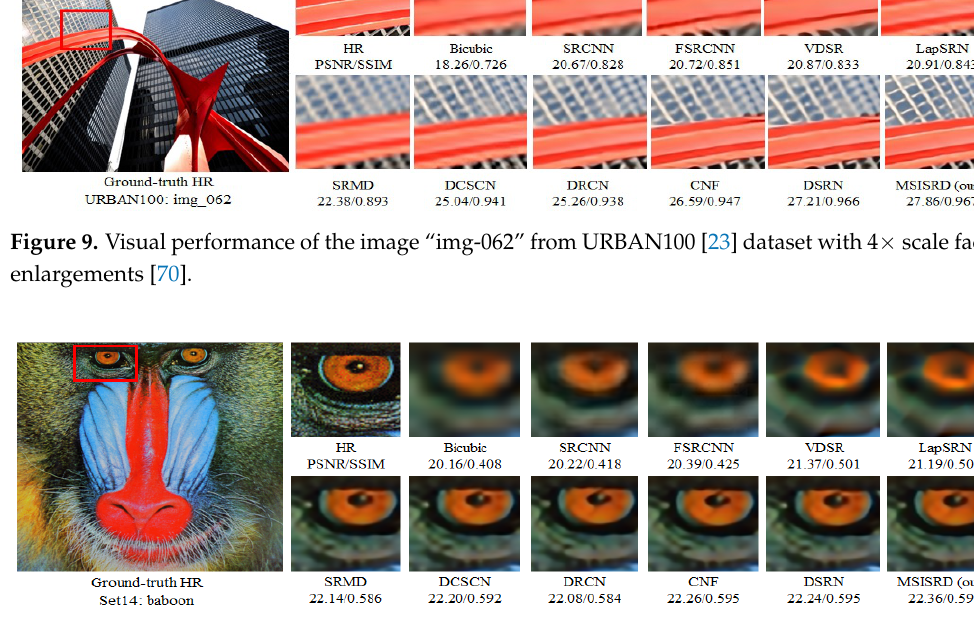
Figure 10. Visual performance of the image “baboon” from Set14 [63] dataset with 8 × scale factor enlargements [71].